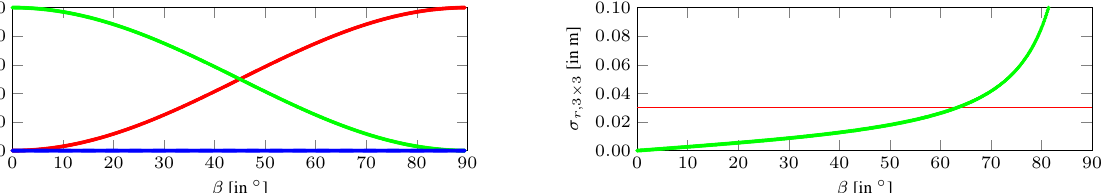
Figure 6. Behavior of the measure σ r, 3 × 3 of range reliability for increasing incidence angles β . The applied threshold of 0 . 03 m is indicated with a red line. Note that the synthetic data is not corrupted with